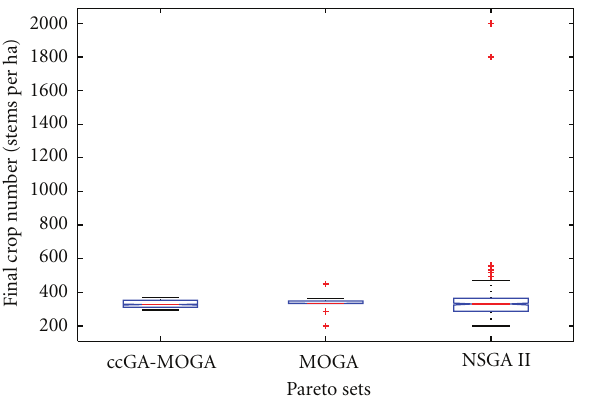
Figure 10: Rotation length box plots from the ccGA-MOGA, MOGA, and NSGA II Pareto sets.